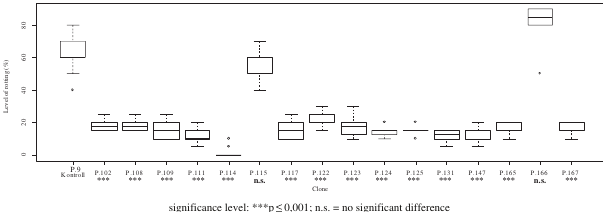
Figure 2. The level of rotting (%) of clone P. 9 and the selected clones of the grapevine variety ‘Kadarka’ (Szekszárd - Batti field, 2010)